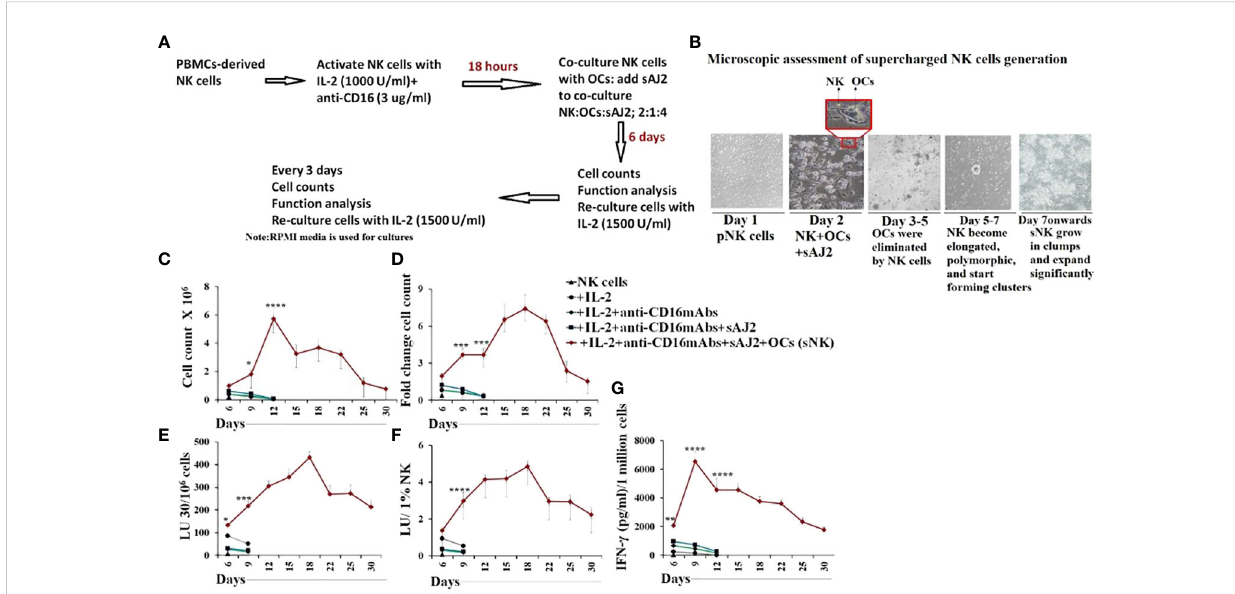
FIGURE 1 Osteoclasts induced higher cell expansion, increased cytokine secretion and cytotoxicity in NK cells in comparison to IL-2, IL-2+anti-CD16mAbs and IL-2 +anti-CD16mAb+sAJ2 treatments Osteoclasts (OCs) were generated as described in the Materials and Methods section. NK cells (0.5x10 6 cells/2ml) were treated with a combination of IL-2 (1000 U/ml) and anti-CD16mAb (3 m g/ml) for 18 hours before they were co-cultured with OCs and treated with sAJ2 (2:1:4: NK : OCs:sAJ2). NK cells were counted on days 6, 9, 12, 15, 18, and onwards until cells are expanding (Average: 24-36 days) (A, B) . NK cells (0.5x10 6 cells/2ml) were left untreated, or treated with IL-2 (1000 U/ml), or a combination of IL-2 (1000 U/ml) and anti-CD16mAb (3 m g/ml), or a combination of IL-2 (1000 U/ml), anti-CD16mAb (3 m g/ml), and sAJ2 (2:4;NK:sAJ2), or a combination of IL-2 (1000 U/ml), anti-CD16mAb (3 m g/ml), sAJ2, and OCs (2:1:4: NK : OCs:sAJ2). NK cells were counted on the days shown in the Figure (C) , and the fold change based on the initial cell count of 0.5x10 6 cells/ 2 mL were determined every 3 days as shown in the fi gure (D) . NK cell-mediated cytotoxicity against oral squamous cell carcinoma stem cell line (OSCSCs)